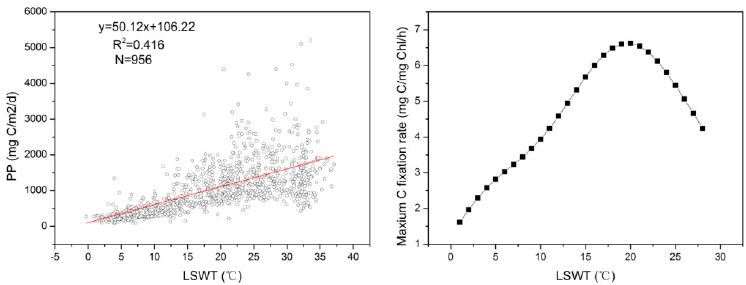
Figure 11. Correlations between water temperature and maximum carbon fixation rate and phytoplankton primary production.